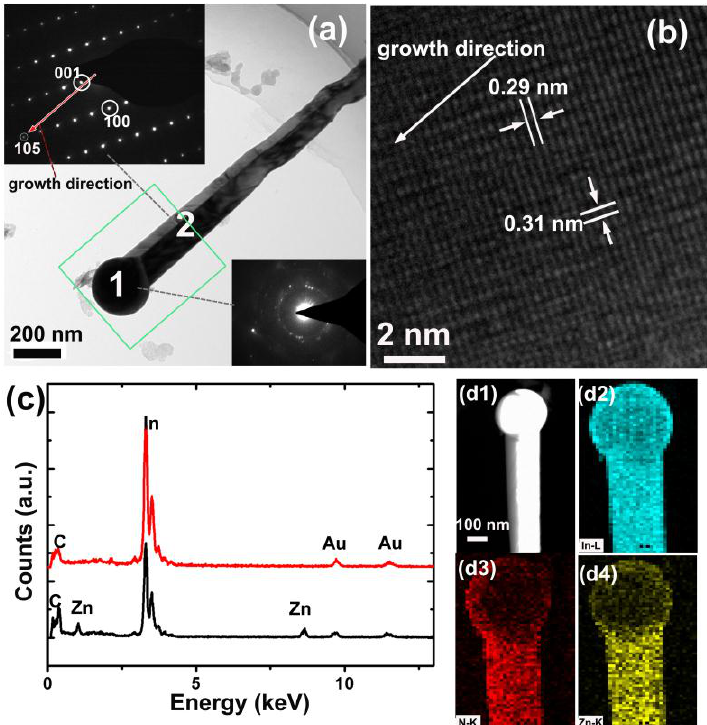
Figure 2. SEM and X-ray diffraction (XRD) characterization of the InN nanowires. Tilted view SEM images of ( a ) the as-grown nanowires and ( b ) the nanowires etched in diluted HCl solution. ( c ) XRD pattern of the nanowires (upper line) and the original brass substrate (bottom line).